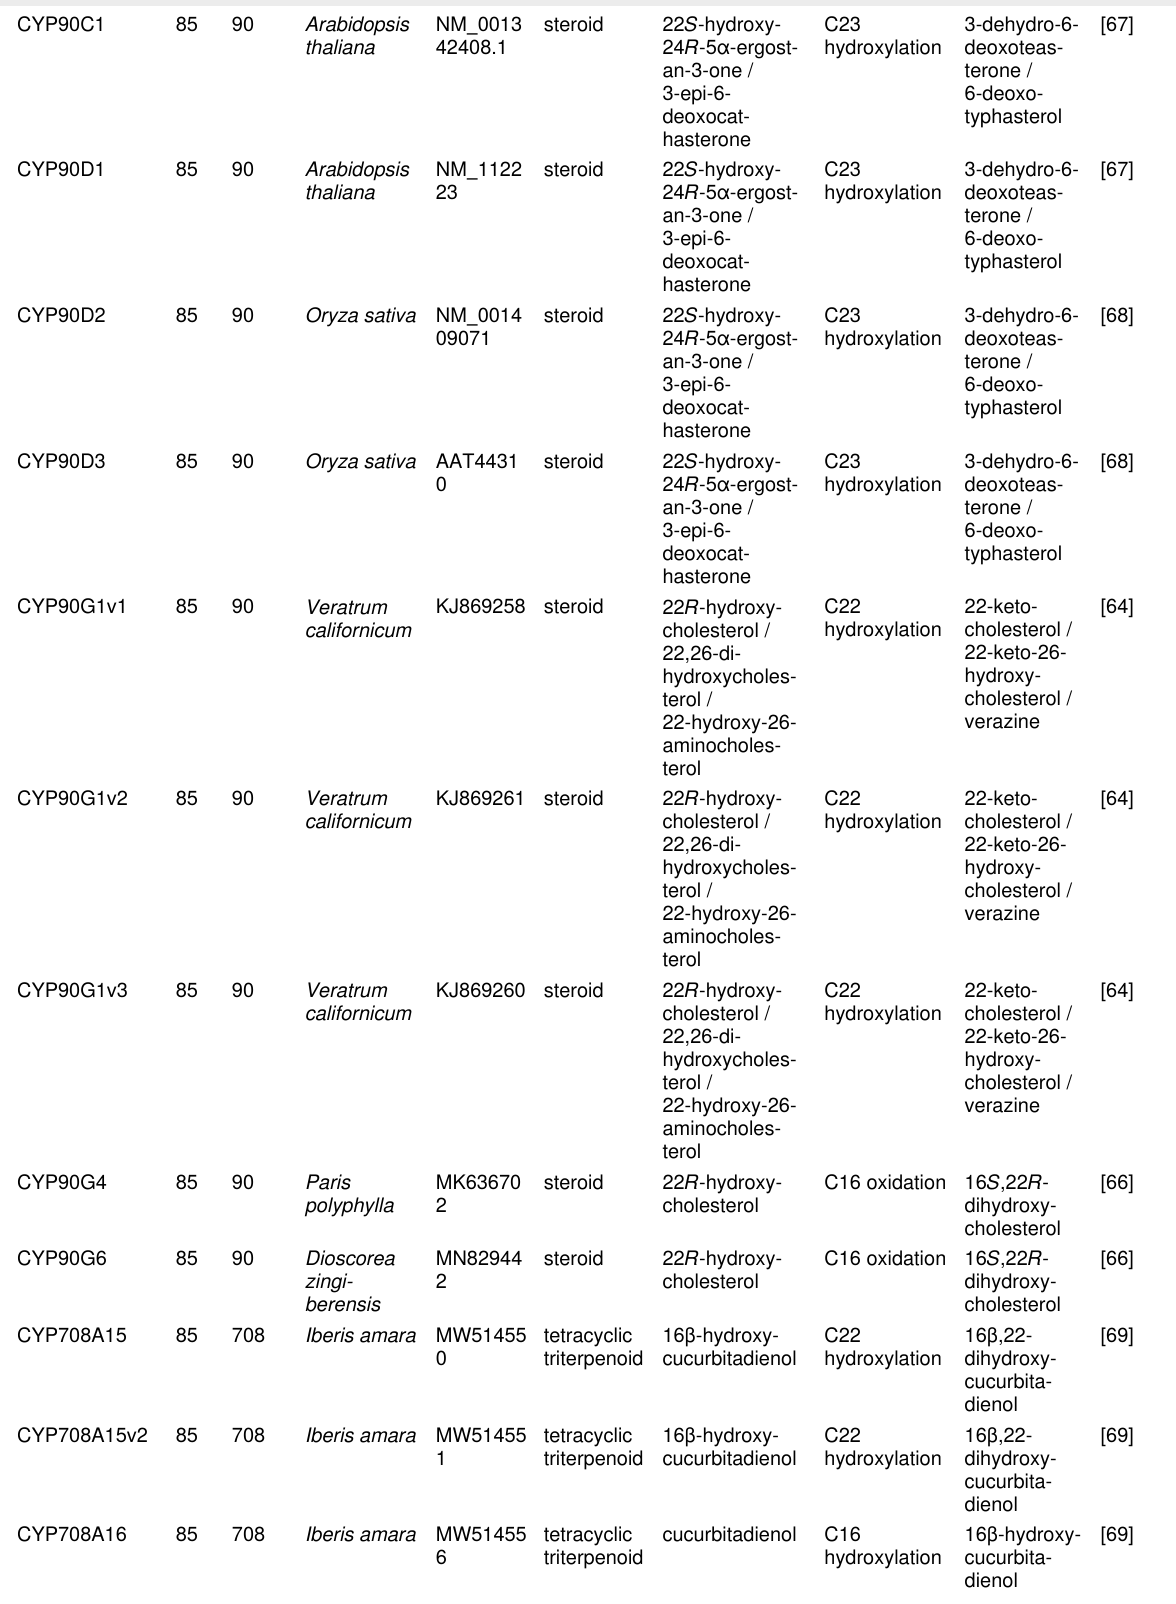
Table 1: List of characterised plant cytochrome P450 monooxygenases (CYPs) modifying triterpenoids or steroids. (continued) CYP90C1